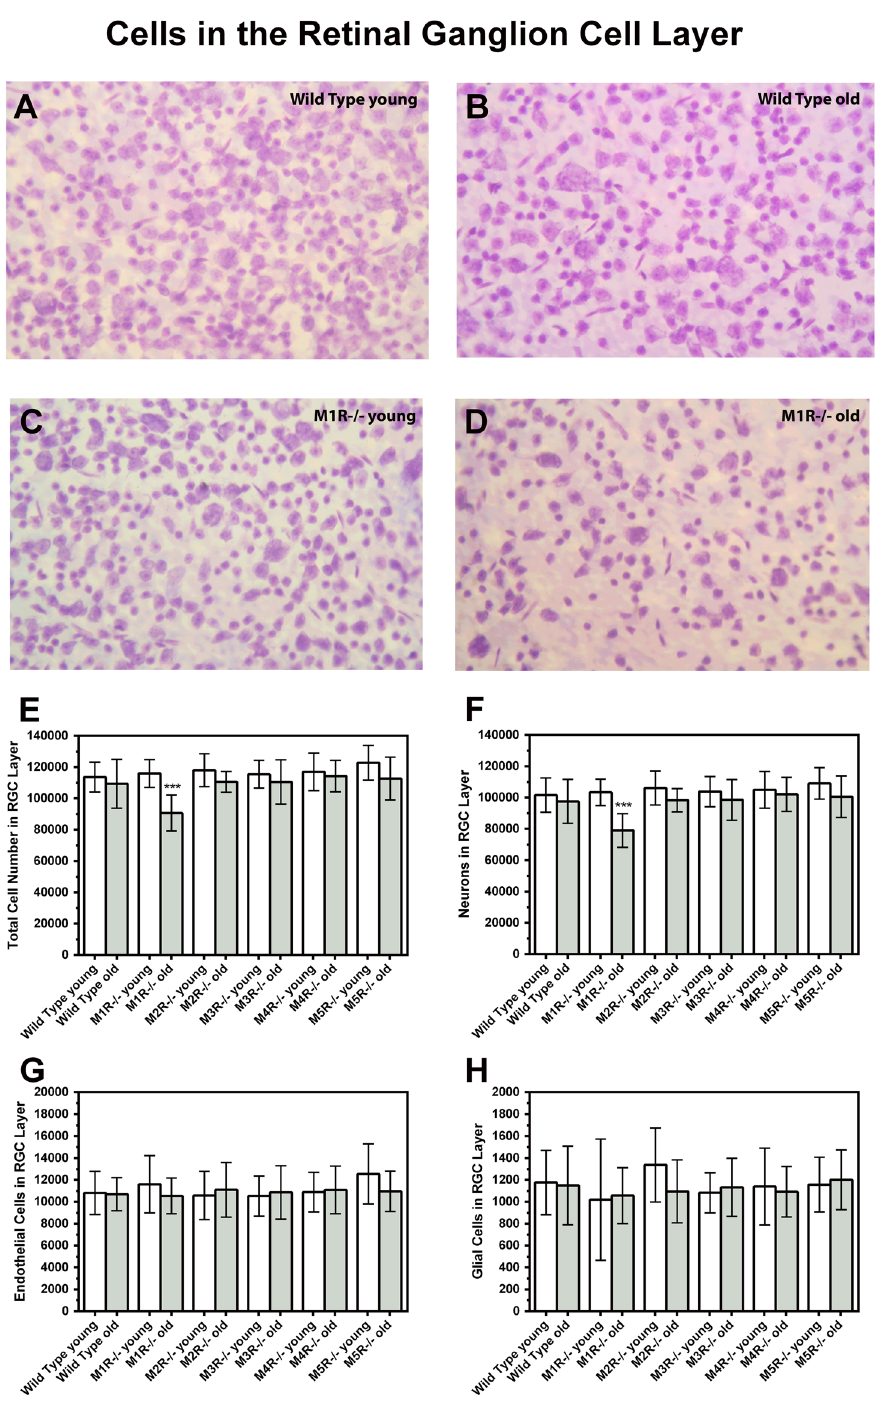
Figure 3. Example photographs taken from retina wholemounts of wild-type and M1R − / − mice at both age categories ( A – D ; scale bars 10 µ m). Total number of cells ( E ), of neurons ( F ), endothelial cells ( G ) and glia cells ( H ) in the RGC layer. The total number of cells and number of neurons in the RGC layer was found lower in old M1R − / − mice than in young mice of the same genetic background ( *** P <